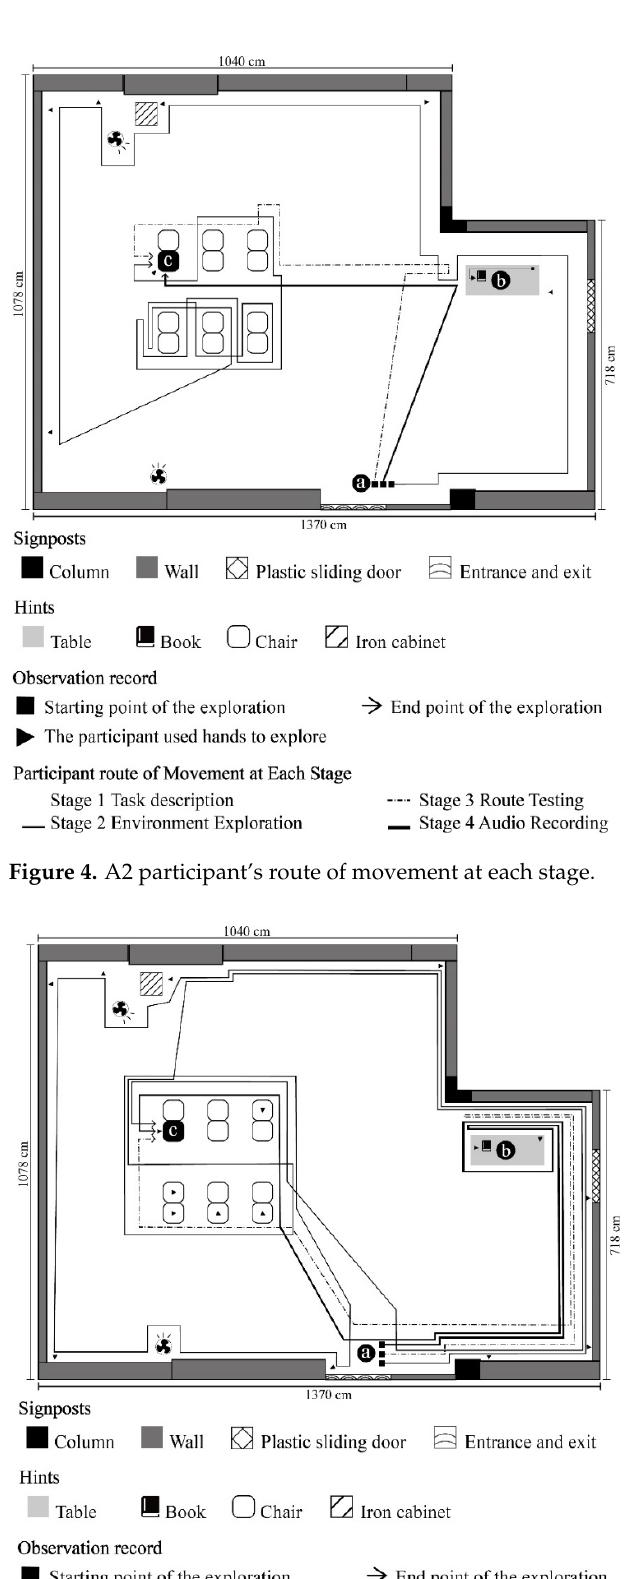
Figure 3. A1 participant’s route of movement at each stage.